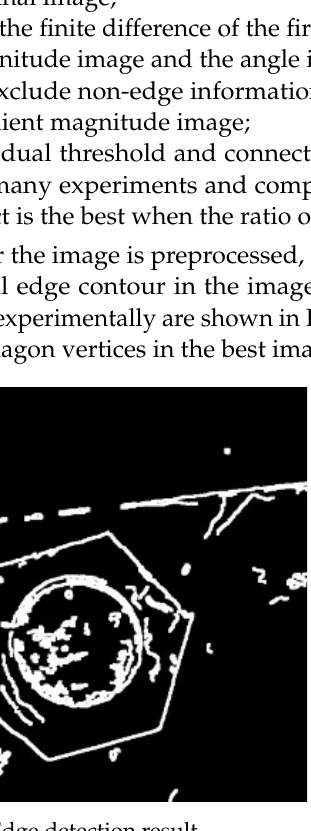
Figure 9. Edge detection